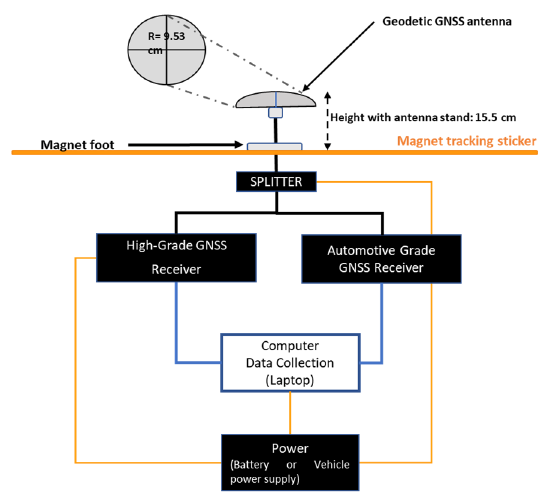
Figure 5. Installation and wiring diagram of the two GNSS receivers with antenna at the vehicle